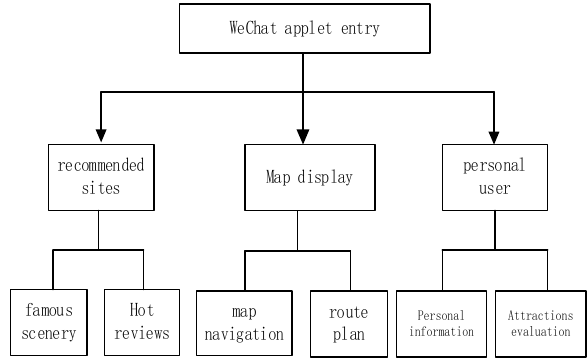
Figure 4. System function organization chart